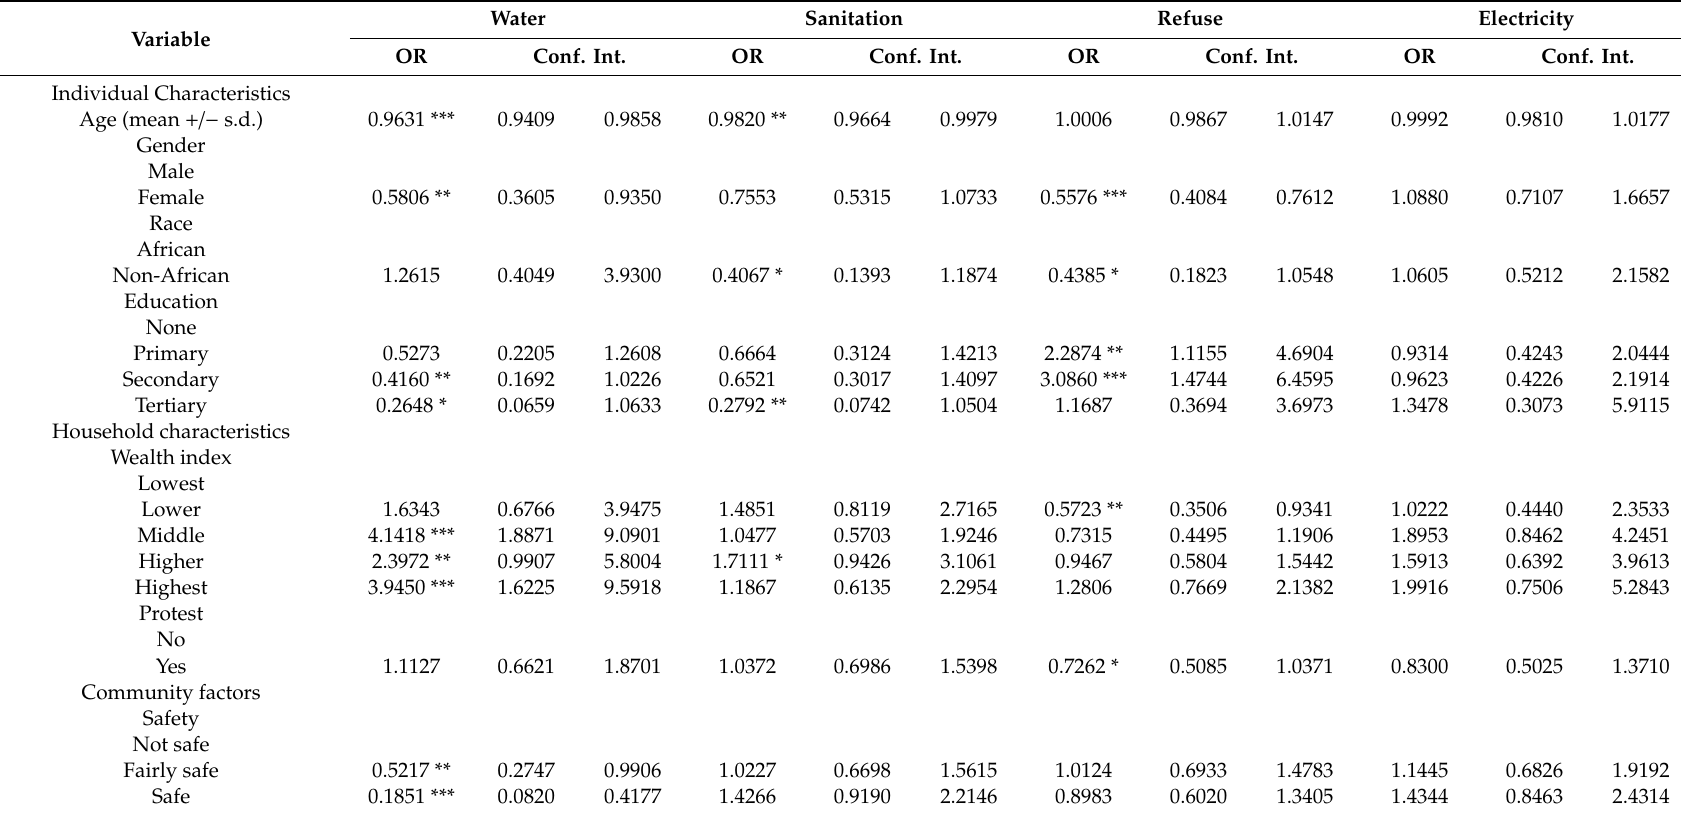
Table 4. Logistic regression analysis of factors associated with neutral satisfaction in basic